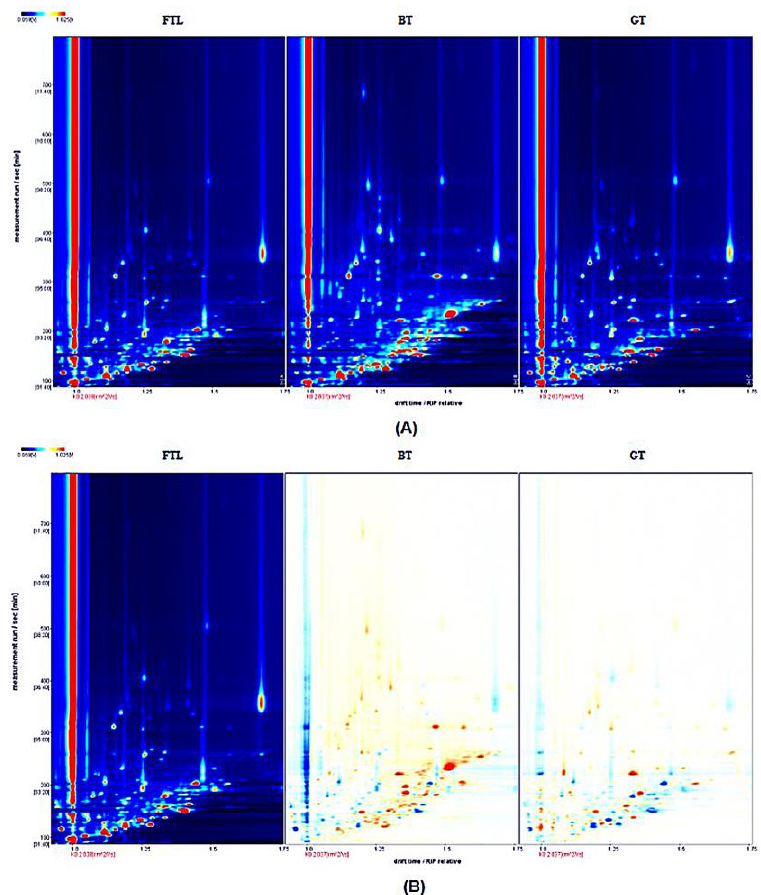
Figure 1. Topographic plots of three tea samples. ( A ) 2D-topographic plot and ( B ) differentiation plot of volatile compounds. In BT and GT, red and blue dots indicated that the concentration of the compounds are higher and lower than the reference (FTL), respectively.